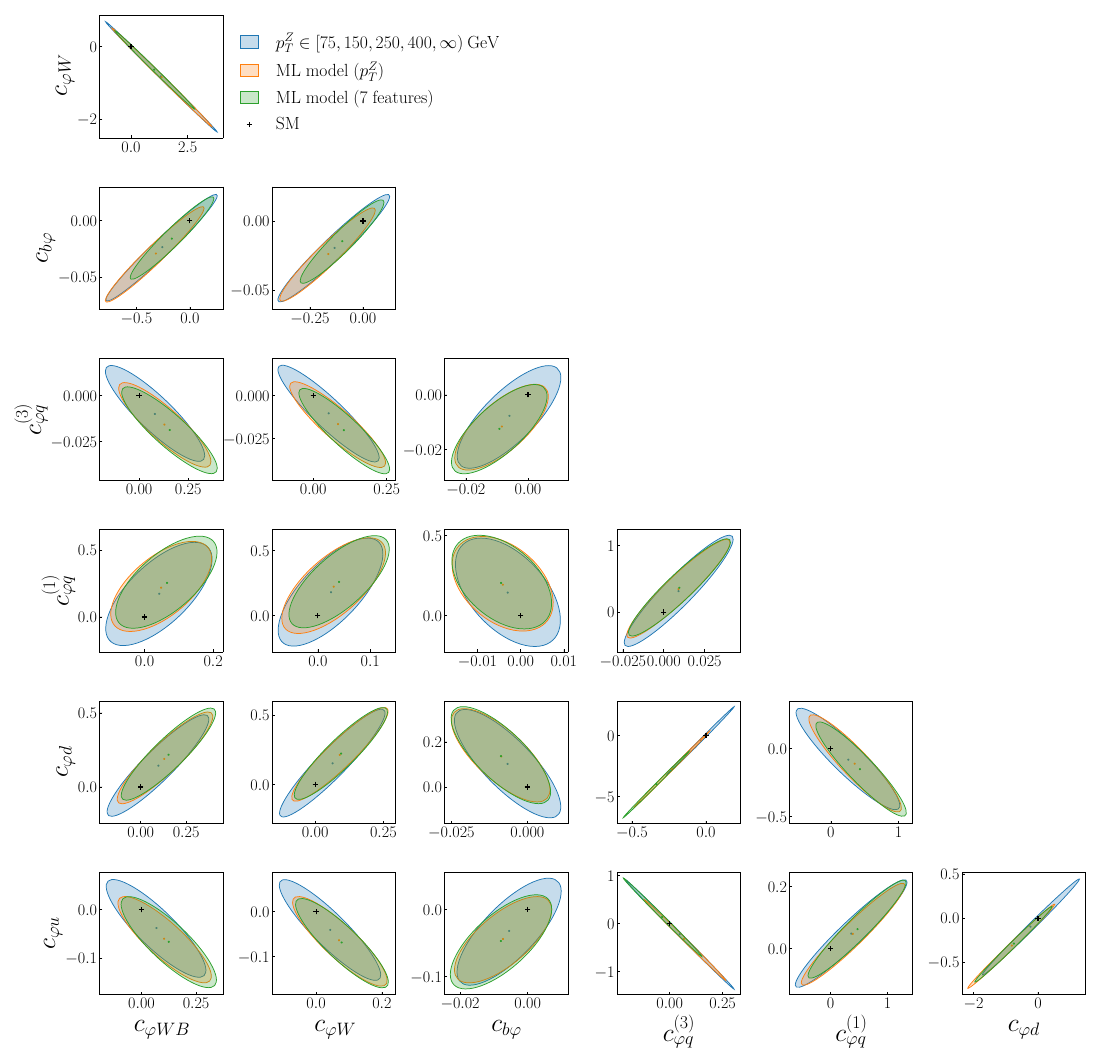
Figure 15. Pair-wise 95% CL contours obtained from two-parameter fits in case of pp → hZ → b ¯ b‘ + ‘ − at the linear level in the EFT expansion for the n eft = 7 Wilson coefficients relevant for the description of this process. For each panel, the contribution from the operators not displayed is set to zero. We compare the bounds obtained from a binned p Z distribution with those from two ML T unbinned observables, first when only p Z is used for the training and then when n k = 7 kinematic T features are used to parametrize the likelihood